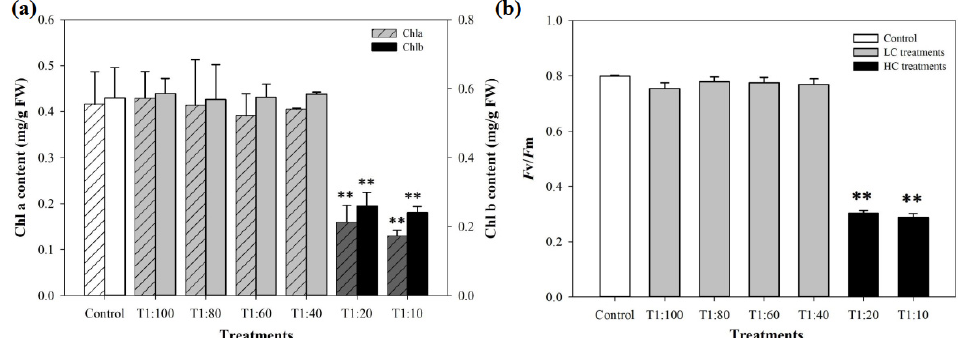
Figure 5. ( a ) The chlorophyll a and b content, and ( b ) the maximum quantum yields of PSII ( F v / F m) of Ulva prolifera under the exposure of di ff erent amounts of cell-free filtrate of Bacillus cereus BE23. Values are means ± SD (n = 3). ** indicates a significant di ff erence ( p < 0.001) compared to